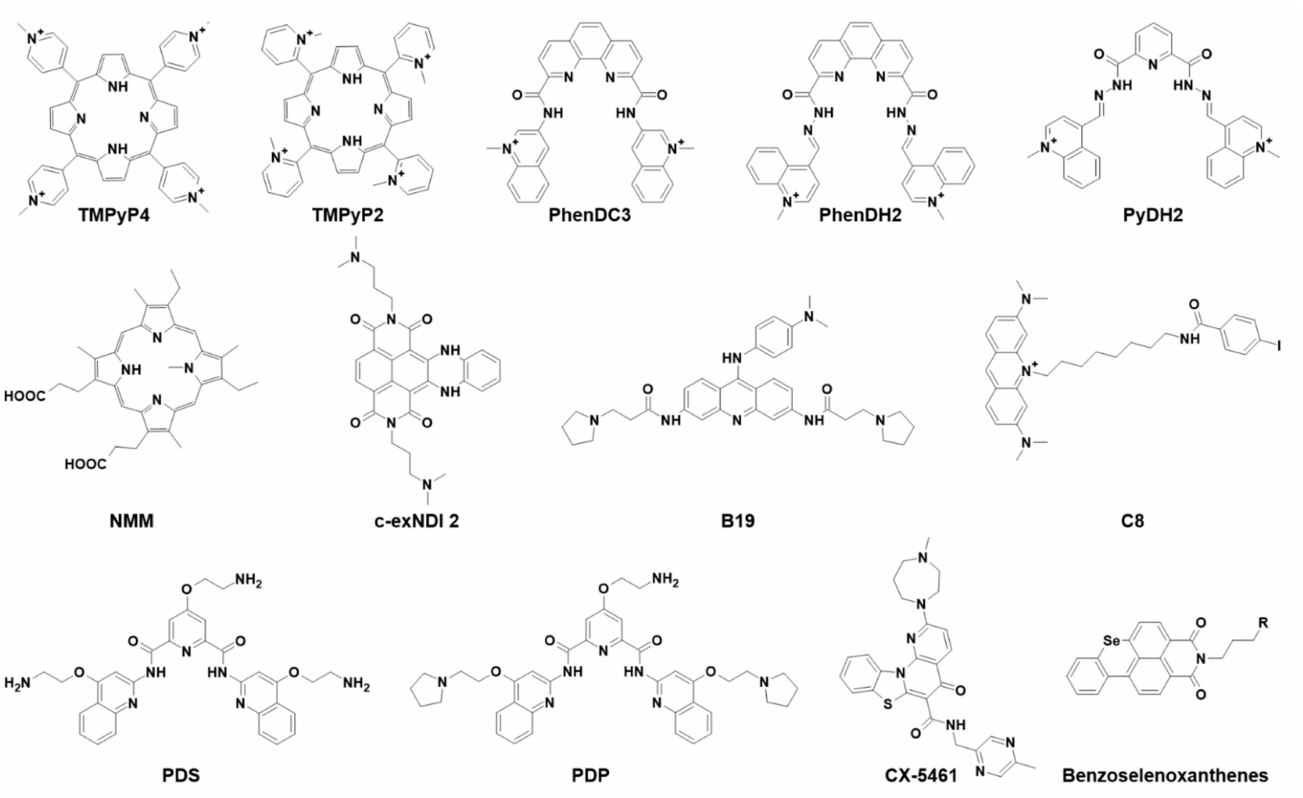
Figure 2. Chemical structures of G4 ligands investigated as antiviral